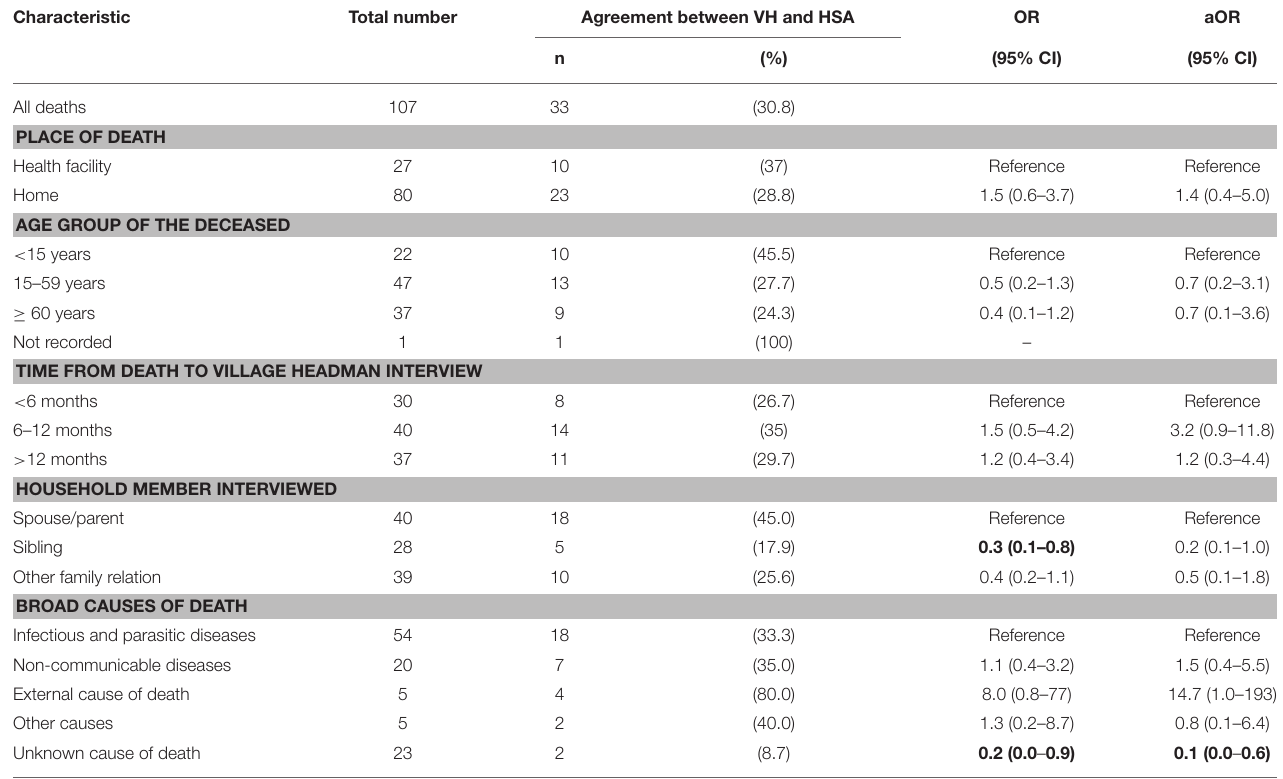
TABLE 4 | Measures of full agreement on specific causes of death in Traditional Authority Mtema, Malawi, between April 2016 and September 2017 as documented by village headmen and health surveillance assistants/medical doctor.